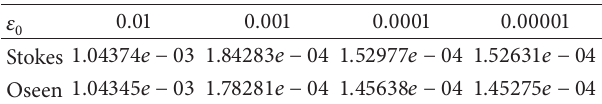
Table 2: Numerical relative error for velocity with 𝐻 = 1/14 and ℎ = 1/115 .